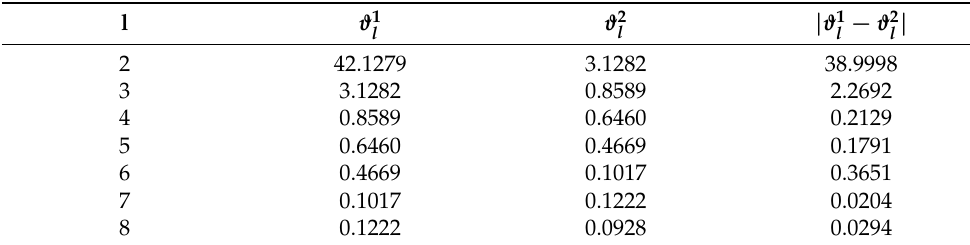
Table 2. ϑ 1 and ϑ 2 values for one resolution cell.